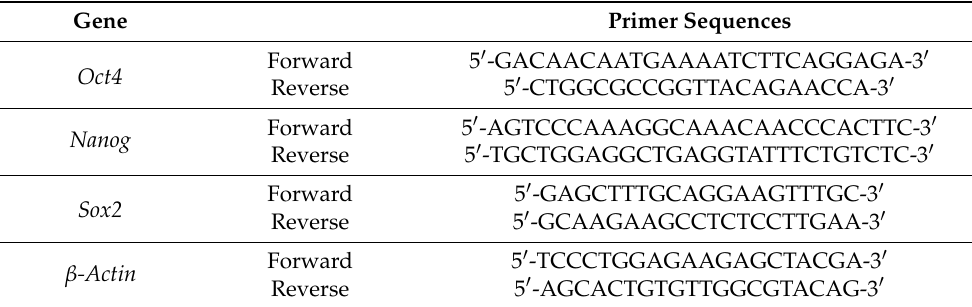
Table 1. Primer sequences used for quantitative real-time